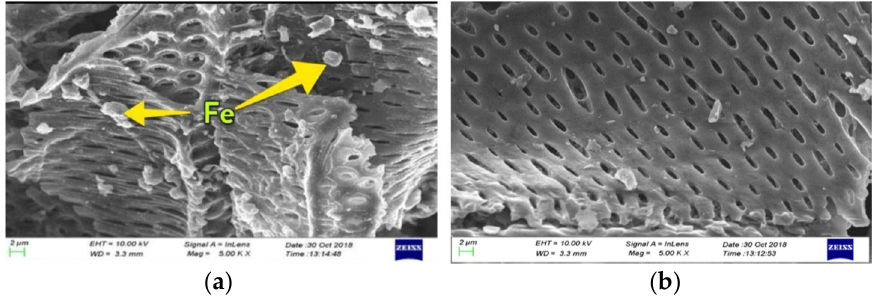
Figure 15. SEM images of Fe-AIB showing ( a ) iron particles in pores, and ( b ) uniform microgrooves on the pore wall. Reprinted from [25], ©2020 The Authors.